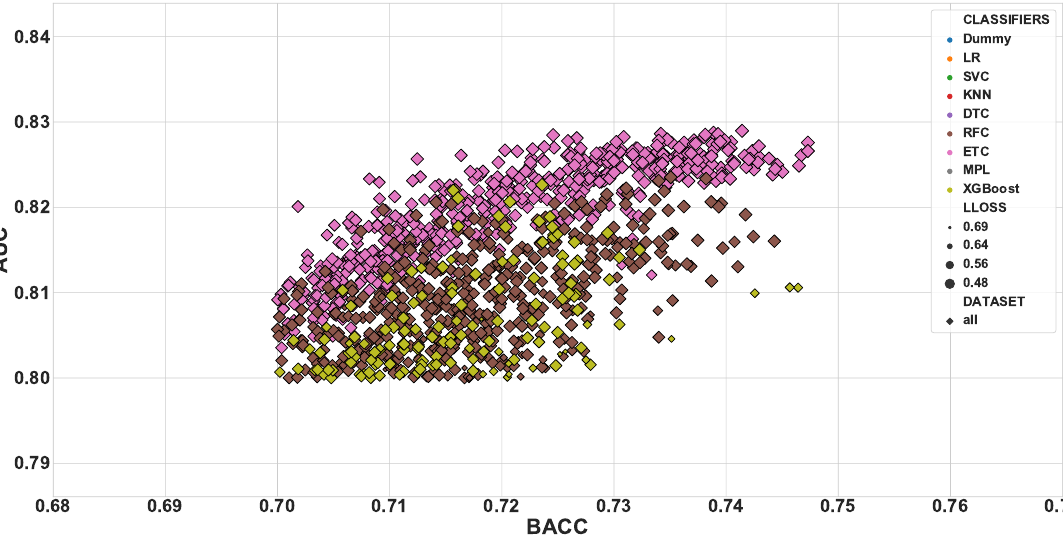
Figure 3. Dispersion (mean balanced accuracy (BACC) vs. mean area under the receiver operating curve (AUC)) of cross-validation scores. Each color represents one type of classifier, while the shape corresponds to the evaluated dataset. The size of each marker is inversely proportional to the value of log-loss (LLOSS; cross-validation mean); thus, bigger markers indicate more reliable classifiers.